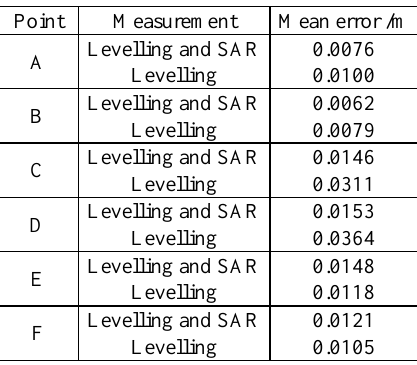
Table 4. The mean error values in six points Above all, the prediction accuracy obtained by levelling and InSAR was obviously better than that only by levelling. So, InSAR measurements were effective for improving the prediction accuracy of exponent Knothe